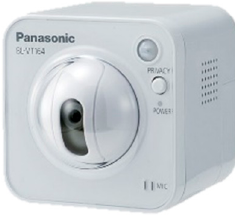
Figure 12. The Panasonic IP camera